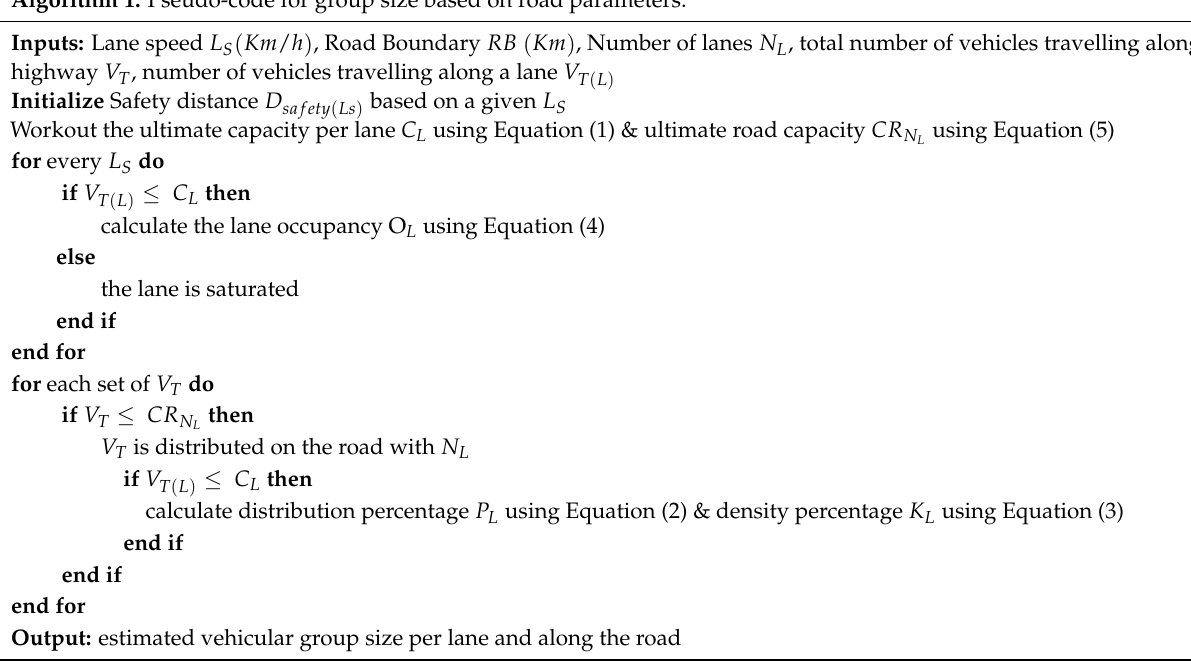
Algorithm 1. Pseudo-code for group size based on road